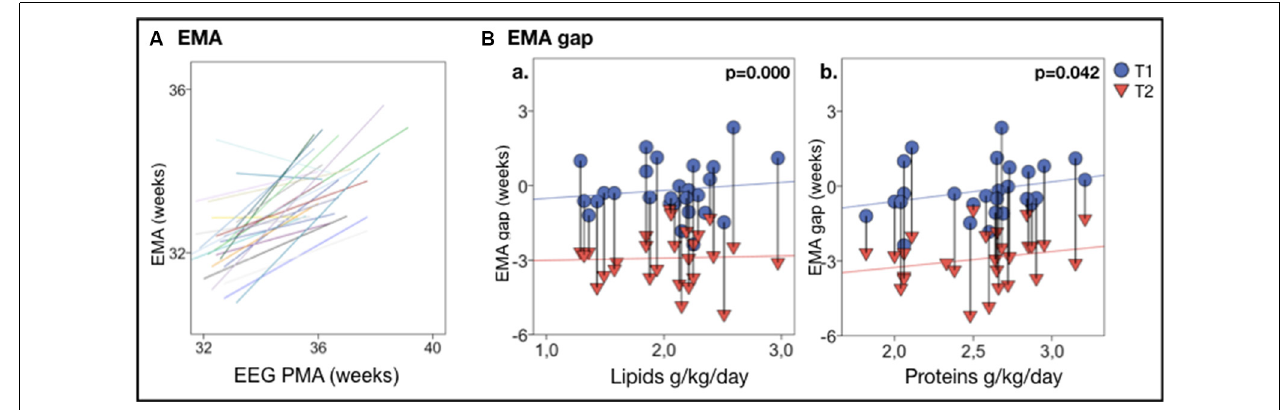
FIGURE 3 | EEG maturational age (EMA) gap vs. nutrition. (A) Individual trajectories of EMA are highly correlated with the actual PMA; a clear developmental increase in EMA between T1 and T2 is displayed in nearly all infants. (B) EMA gap vs. nutrients intake in the first week of life, shows that higher lipids (Ba) and proteins (Bb) intake correlate with less EMA gap. Vertical lines connect individuals’ EEG metrics from T1 and T2; p -values refer to GEE models that account for PMA at both recordings.